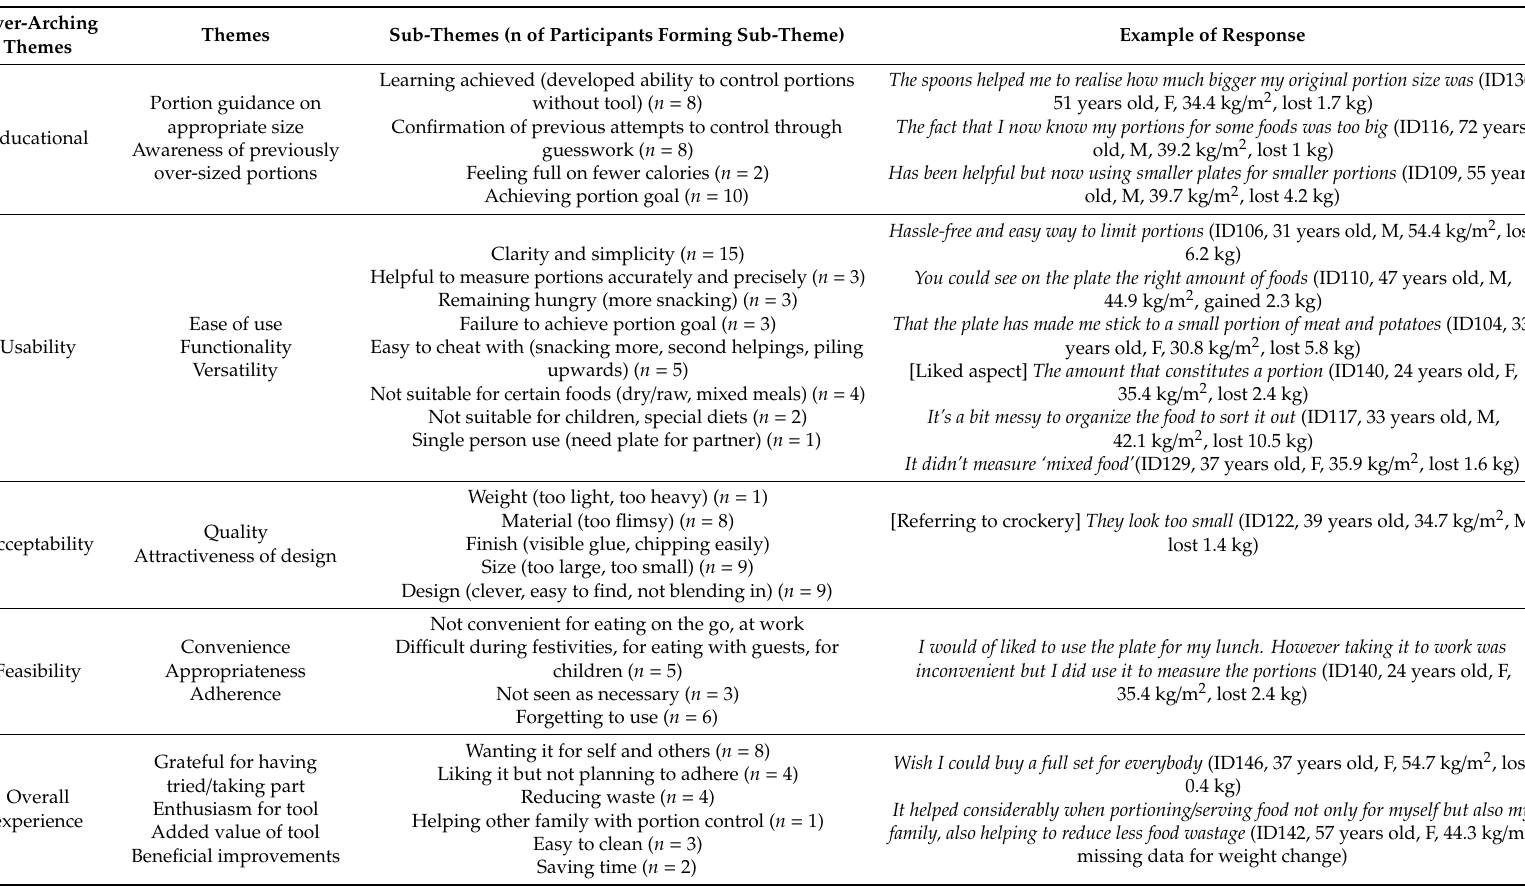
Table 2. Results from the thematic framework analysis of responses to an open-ended questionnaire on the portion-control tool experience ( n = 29). Overarching theme categories, themes and sub-themes are indicated, alongside examples of participant responses. The number of responses that fell into each category is indicated under each